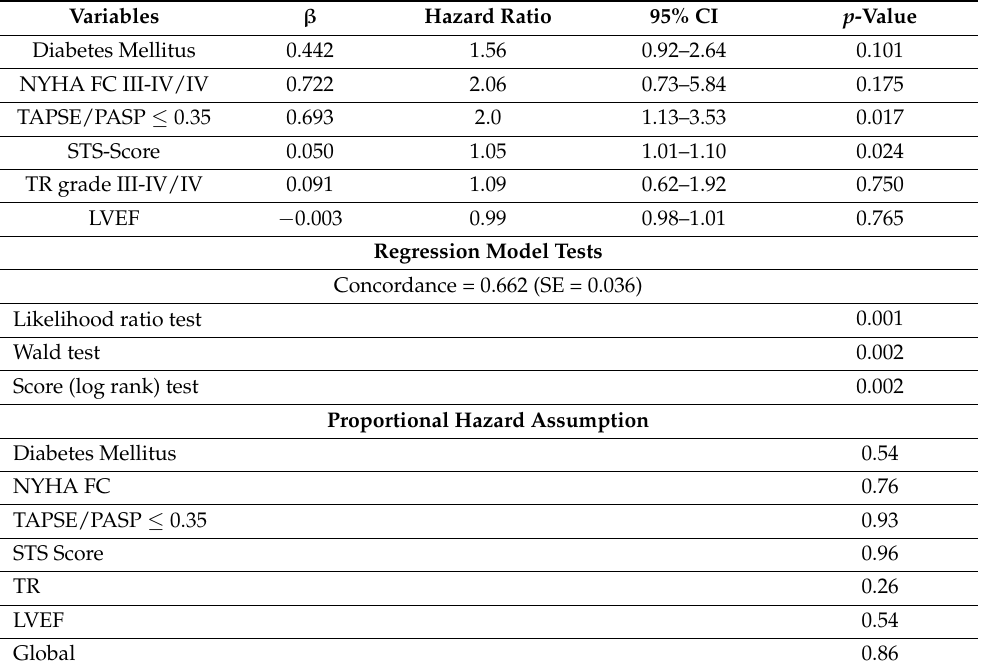
Table 3. Multivariate Cox Regression Analysis.